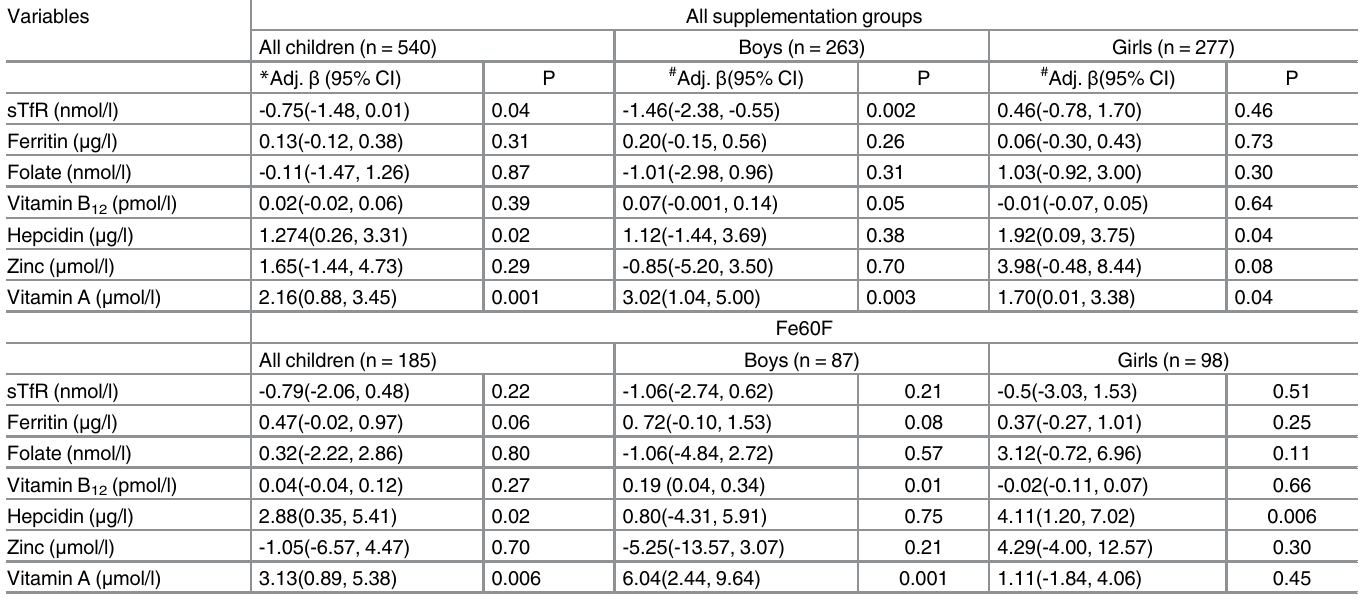
Abbreviation: Fe60F, 60mg iron and 400 μ g folic acid; sTfR, soluble transferrin receptor. Data were given as regression coef fi cient ( β ) and 95% con fi dence intervals